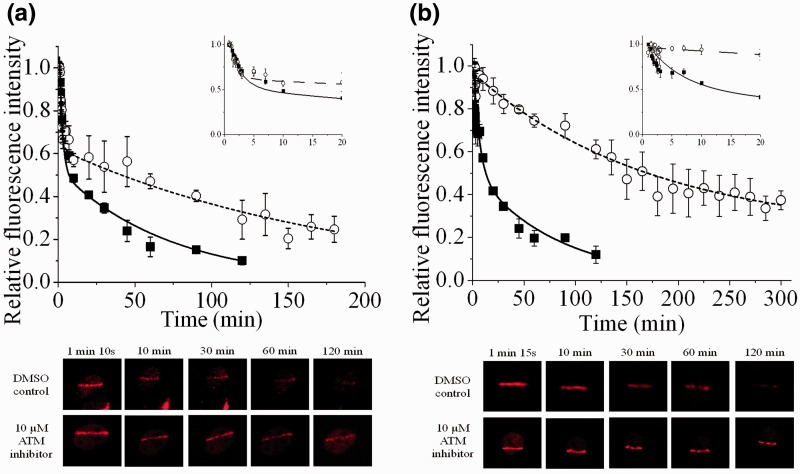
Effects of 10 µM ATM kinase inhibitor on the real-time recruitment and loss of fluorescence intensity of (a) Ku80-EGFP and (b) DNA-PKcs-YFP following NIR microbeam irradiation of Ku80-EGFP and DNA-PKcs-YFP tagged cells, respectively, with 730 nm photons (at a power of 10 mW using ×60 objective) and at 37°C. The kinetics of loss of fluorescence intensity of the respective proteins in Dimethylsulfoxide (DMSO)-treated control cells (black boxes) and cells treated with ATM inhibitor (open circles) were analysed and represent the mean of three independent experiments ± SEM with the solid (control) and dotted (inhibitor) lines showing the fit of the exponential decays to the data points. The insets represent the data expanded to show the first 10 min in more detail. The images are representative of the fluorescence level over the repair time course in control and ATM inhibitor treated cells.